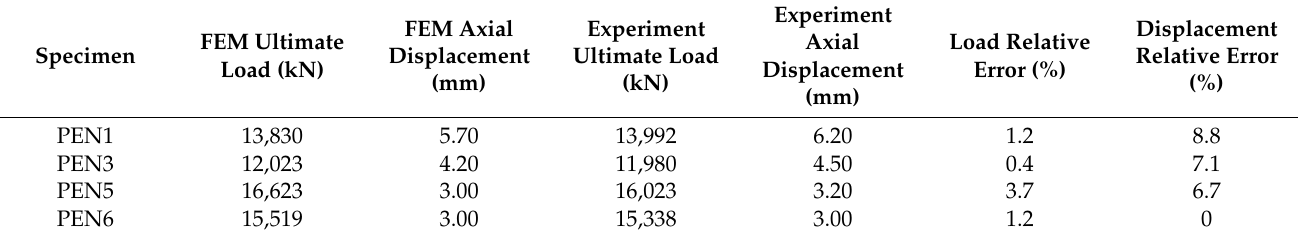
Table 5. Comparison between the FEM results and the experimental